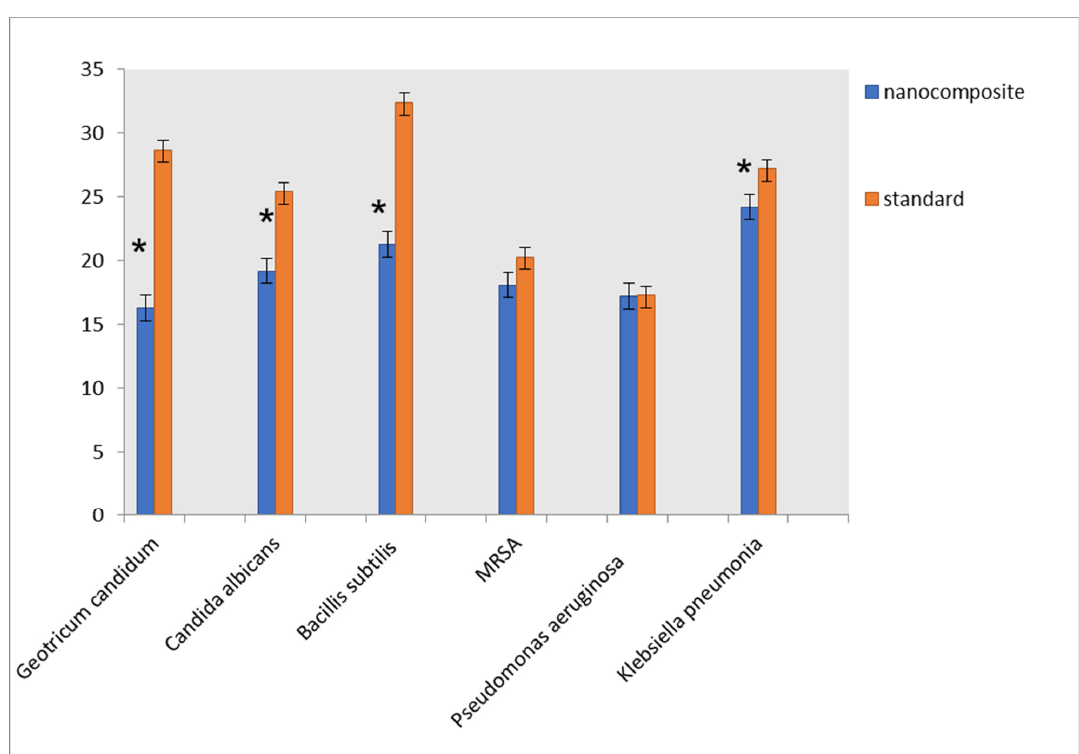
Figure 11. Antimicrobial activity and MIC of nanocomposite for different microorganisms. * studied composite is statistically significant from the standard at p values less than 0.05.